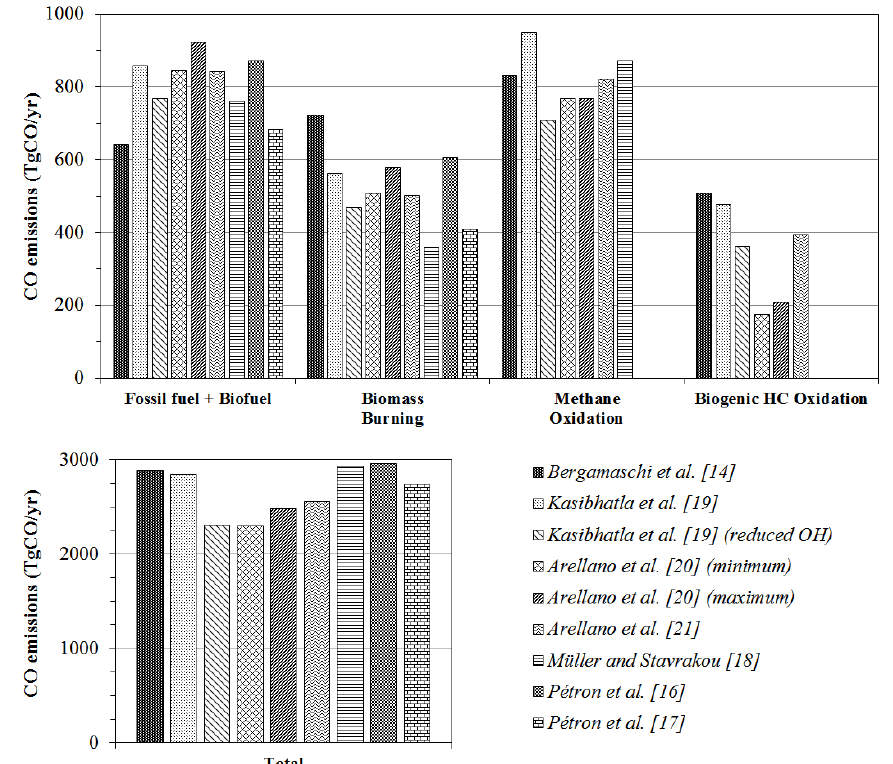
Figure 1. Carbon monoxide (CO) sources and total amount of CO emissions derived from inversion analyses.